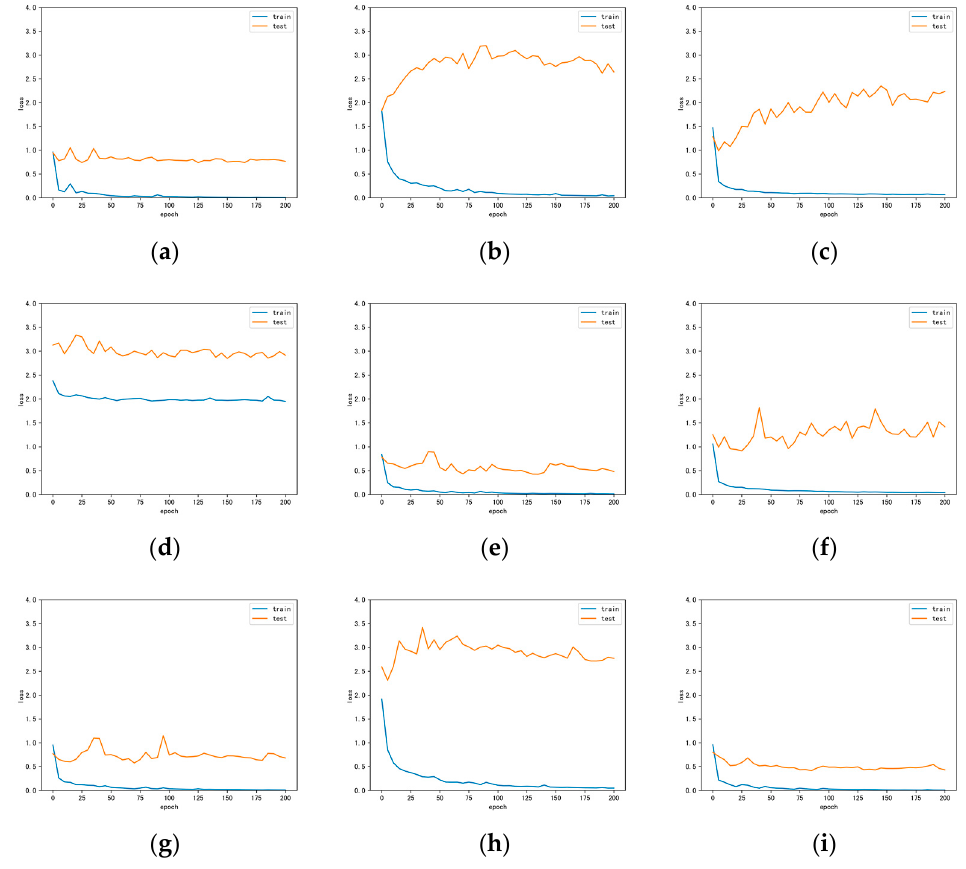
Figure 9. Loss curves obtained by different methods for the Houston dataset. ( a ) CNN-H; ( b ) CNN-L; ( c ) miniGCN-H; ( d ) miniGCN-L; ( e ) CCNet-HL; ( f ) CGNet-HL; ( g ) DCCGNet-H; ( h ) DCCGNet-L; ( i )